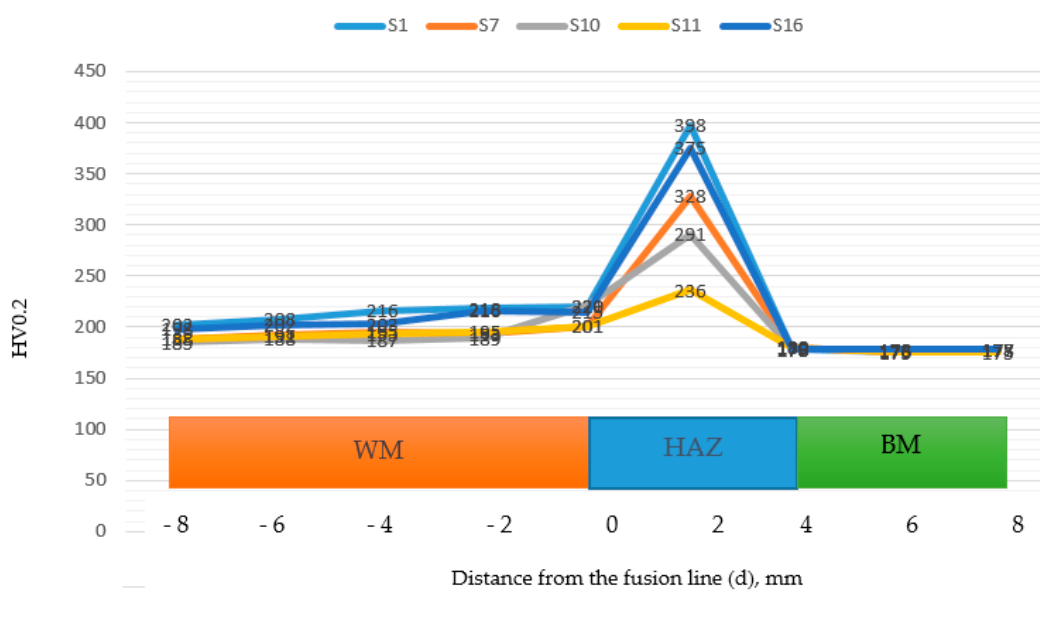
Figure 5. Variation of hardness of the samples materials.